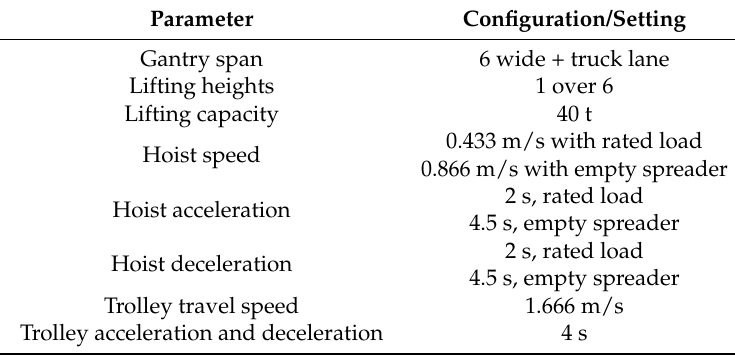
Table 1. Crane specifications.